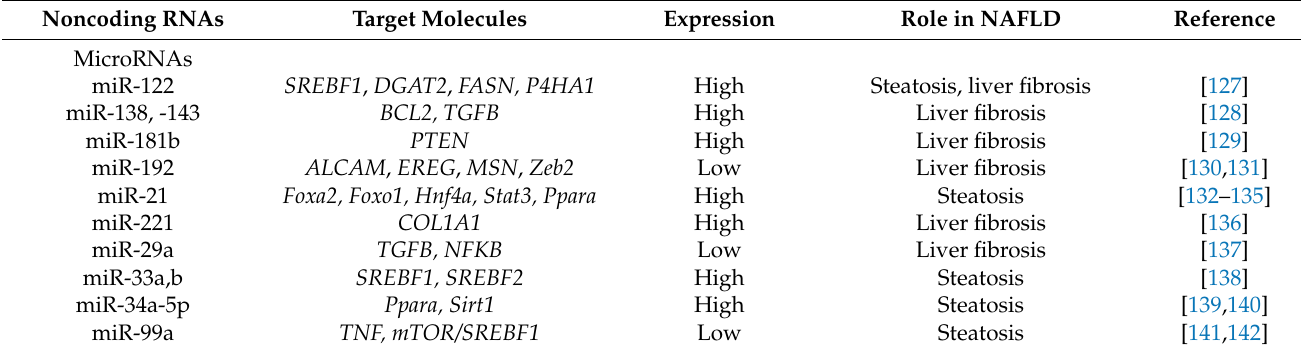
Table 2. Summary of the noncoding RNAs in